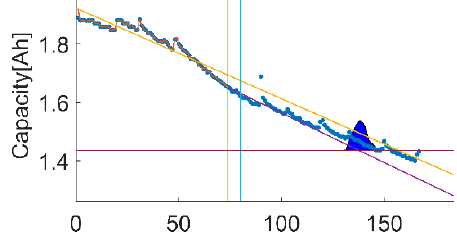
Figure 15. Time-instant figure of test 1 on t 65 .